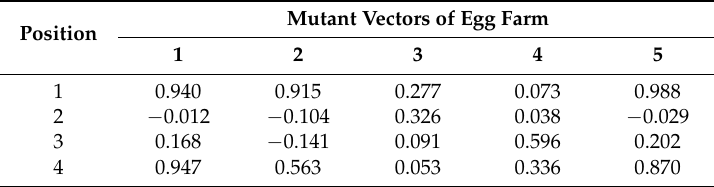
Table 11. Mutant vectors of egg